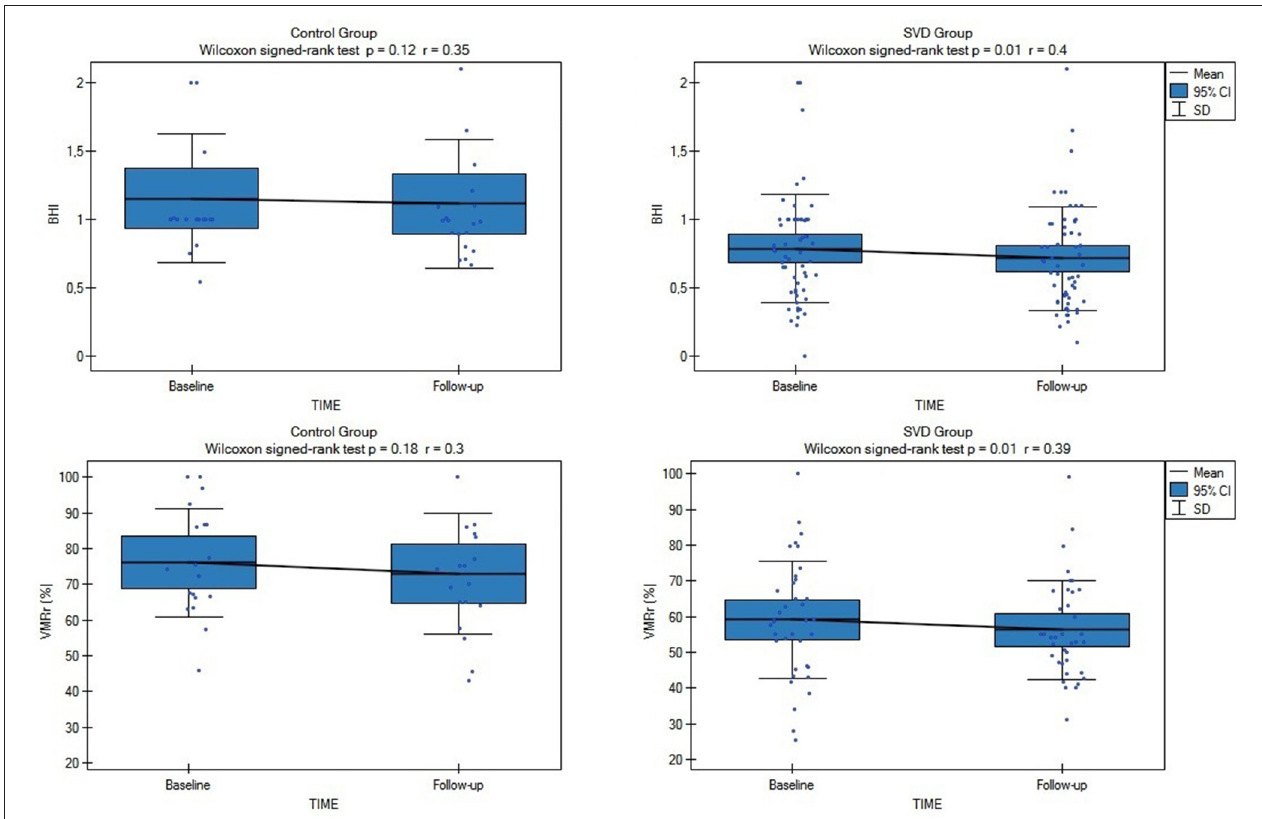
FIGURE 1 | Comparison of baseline and follow-up cerebrovascular reactivity (CVR) measures (VMRr [vasomotor reactivity reserve] and breath-holding index [BHI]) in all subjects from cerebral small vessel disease (SVD) and control group (CG). SVD, cerebral small vessel disease; VMRr, vasomotor reactivity reserve; BHI, breath-holding